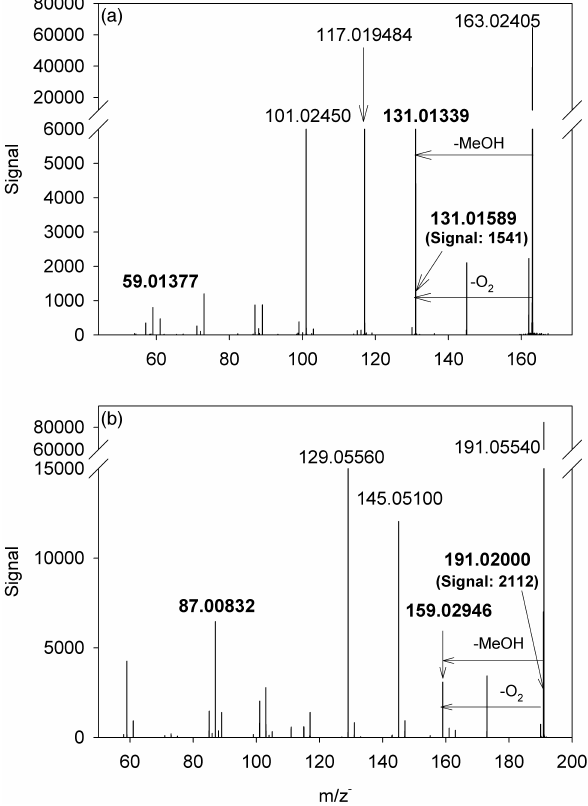
Figure 7. FTICR-MS/MS for m/z − 163 for PHA 1 (a) and m/z − 191 PHA 2 (b)